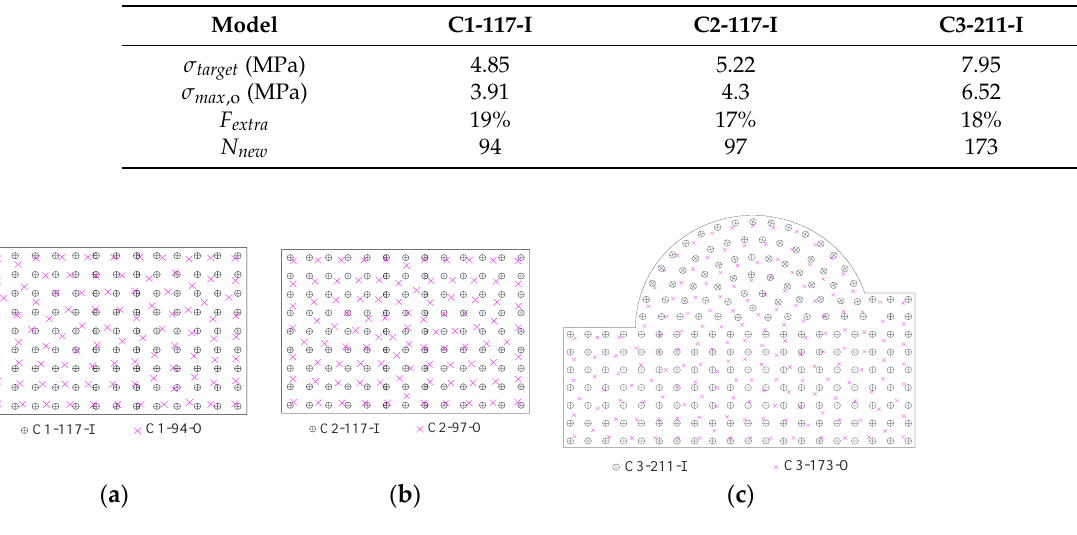
Figure 11. Pile arrangements of initial designs and AOM-ES: ( a ) initial design and AOM-ES (C1-94-O) of Case 1; ( b ) initial design and AOM-ES (C2-97-O) of Case 2; ( c ) initial design and AOM-ES (C3-173-O) of Case 3.